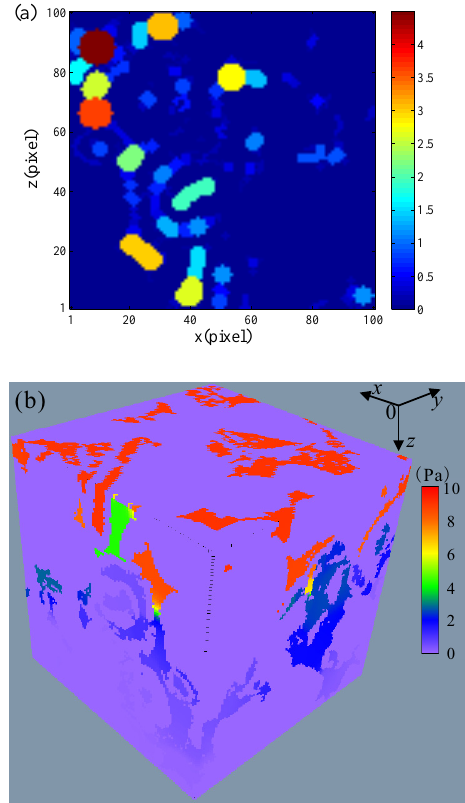
Figure 22. The distribution of coefficients wy and pressures of carbonate digital rock C1 after grid coarsening four times. ( a ) The calculation results of coefficients wy for one-cell thick layer in direction of y . ( b ) The fluid pressure distribution of carbonate digital rock C1. The constant pressures at the inlet and outlet faces are 10 Pa and 0 Pa, respectively.